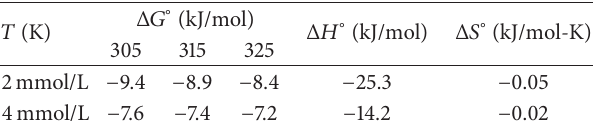
Figure 6: Change in distribution coefficient as affected by tempera- ture for AT adsorption on kaolinite. Table 1: Thermodynamic parameters of AT adsorption on